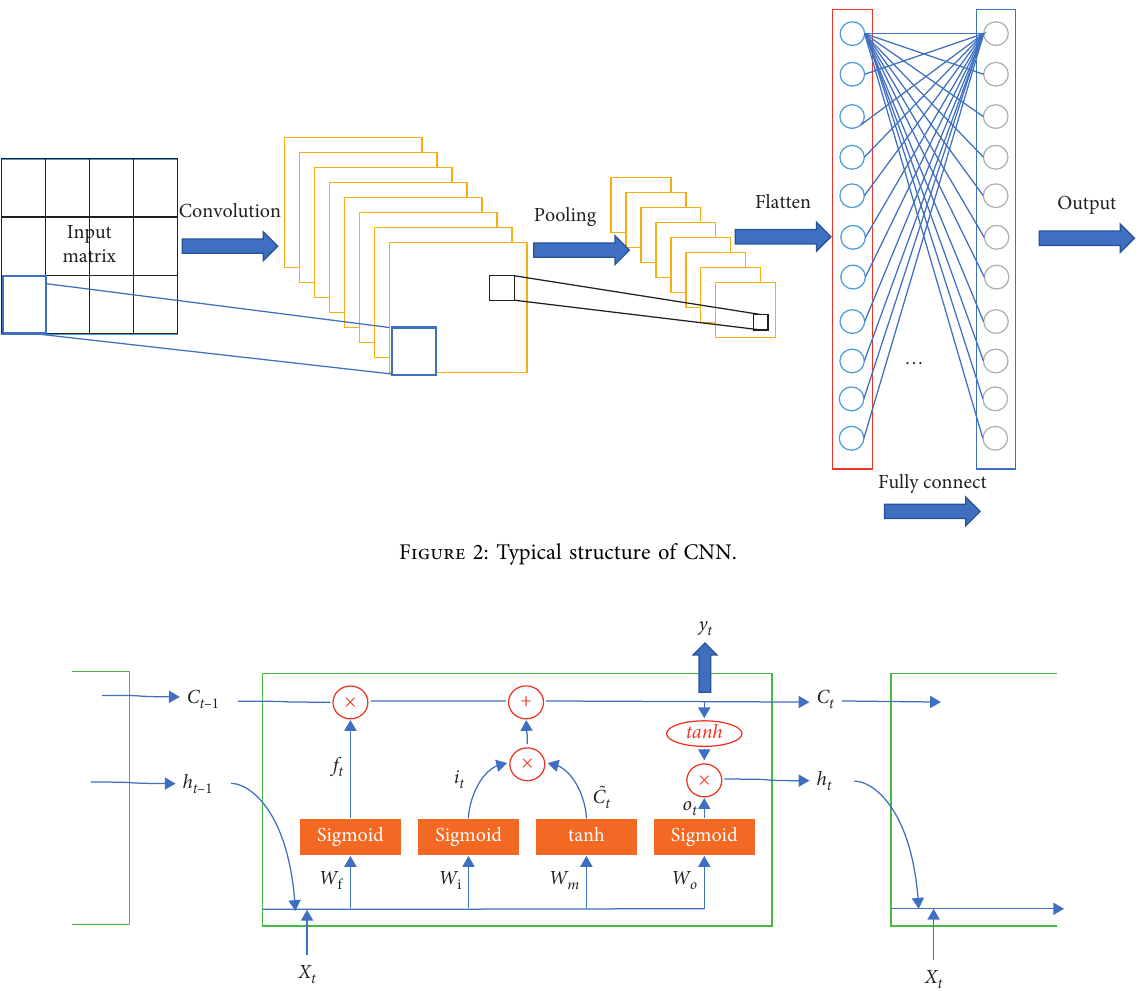
Figure 3: Structure of LSTM. X represents the input of the previous node received. and h t − 1